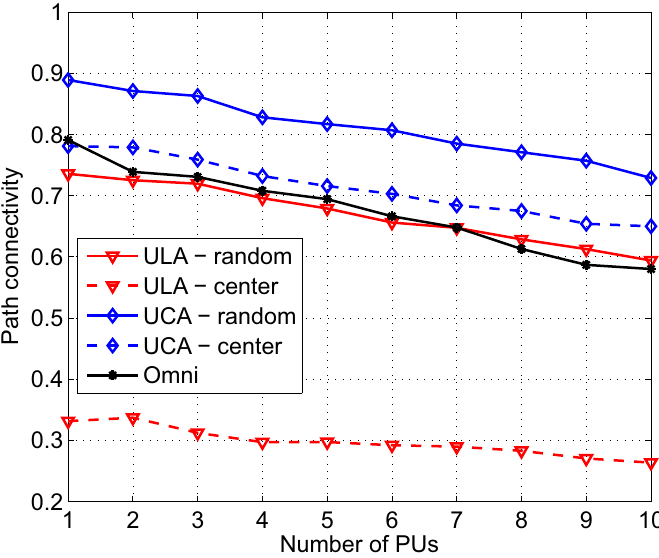
Figure 7. Path connectivity corresponding to different kinds of antennas and beamforming schemes as a function of the number of PUs; a = 500 m, M = 6, N S = 200, λ P = 0.5, α = 3, γ th = 50